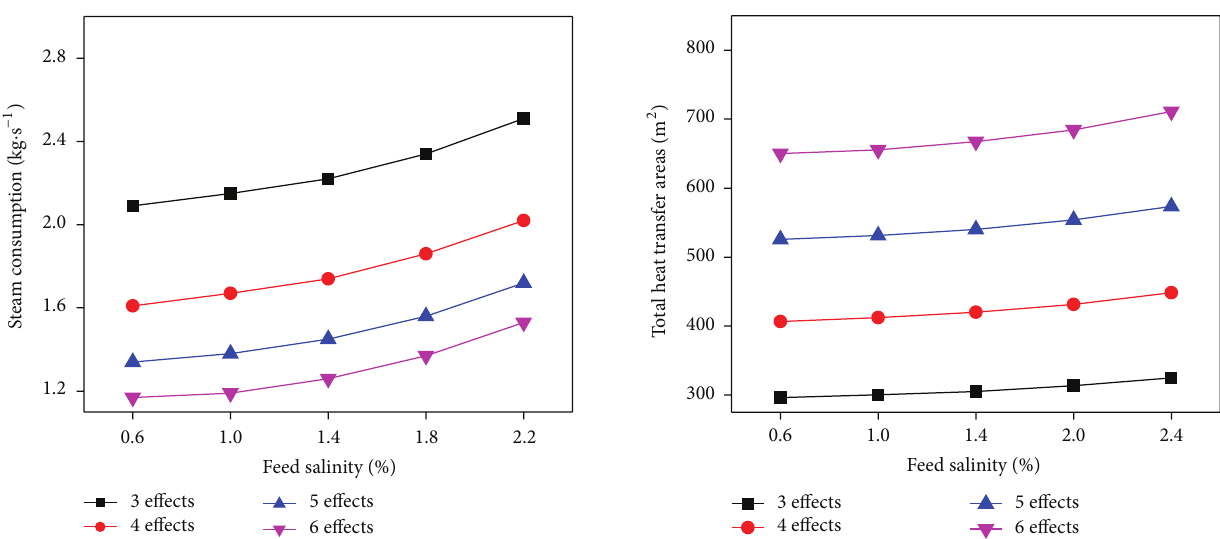
Figure 7: Variation of total heat transfer areas with feed salinity.